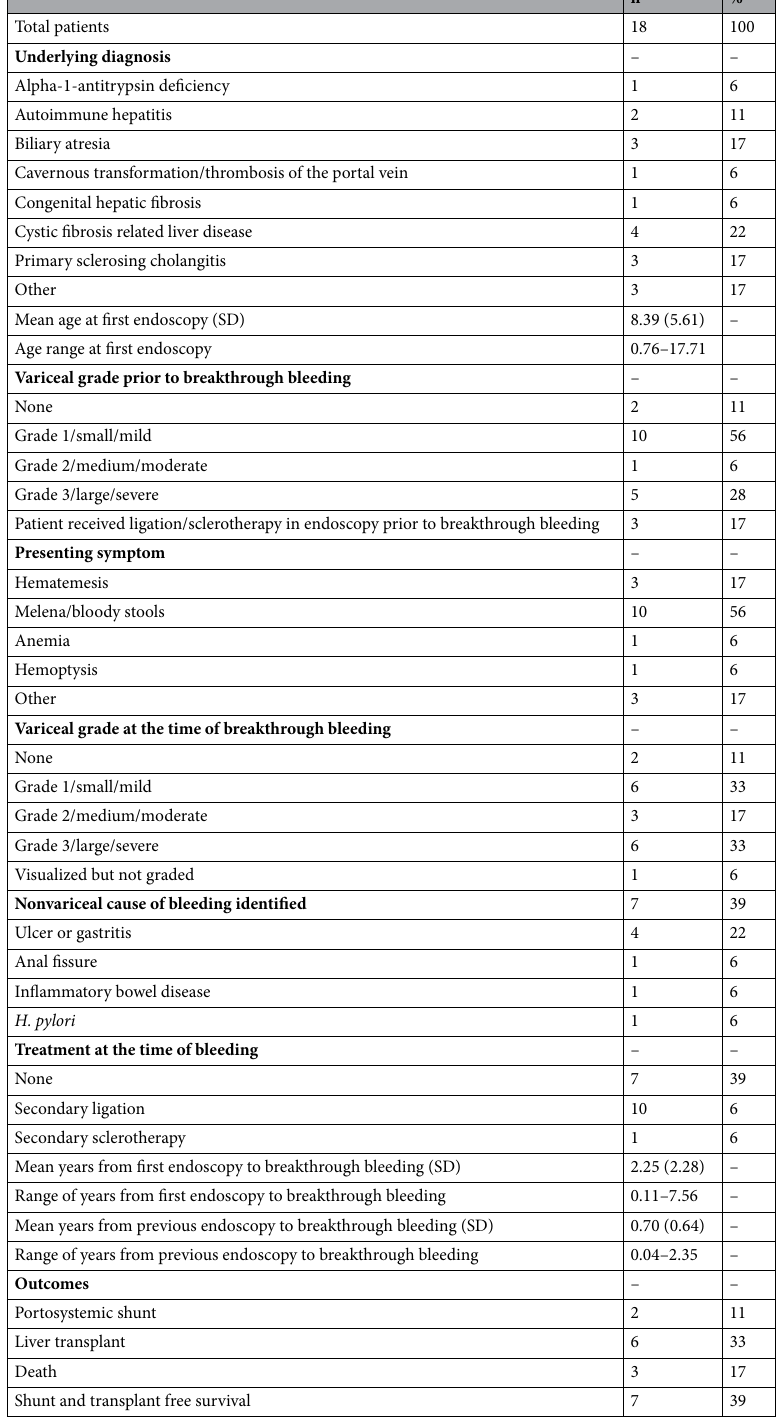
Table 3. Characteristics of those with breakthrough bleeding despite primary